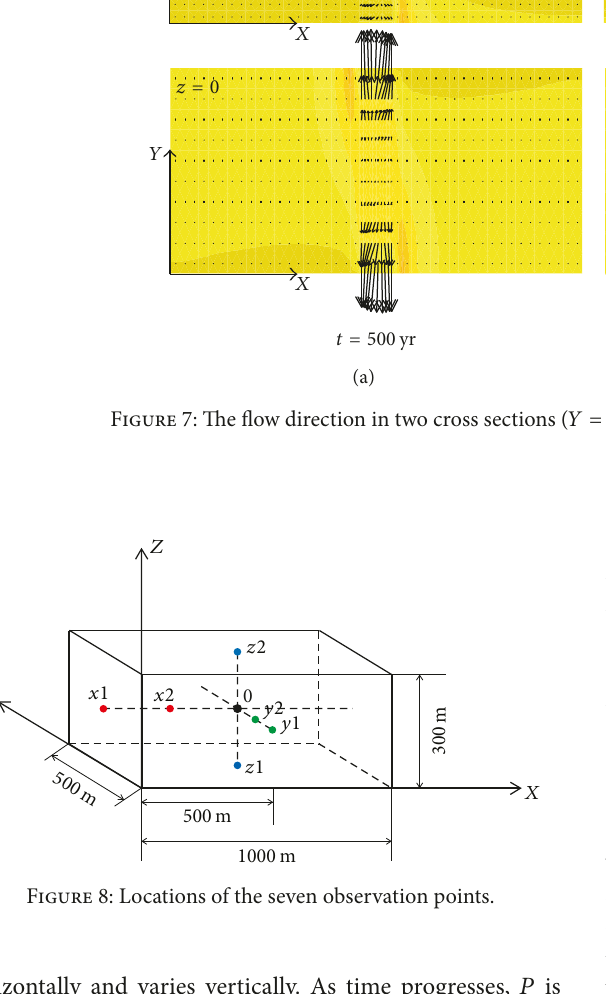
horizontally and varies vertically. As time progresses, 𝑃 is more and more concentrated around the sides of the fault zone and the positive 𝑃 (the yellow-red areas in Figure 6) and the negative 𝑃 (the blue areas) are in opposite directions on the two sides of the fault zone due to the concentrated 𝑆 max .